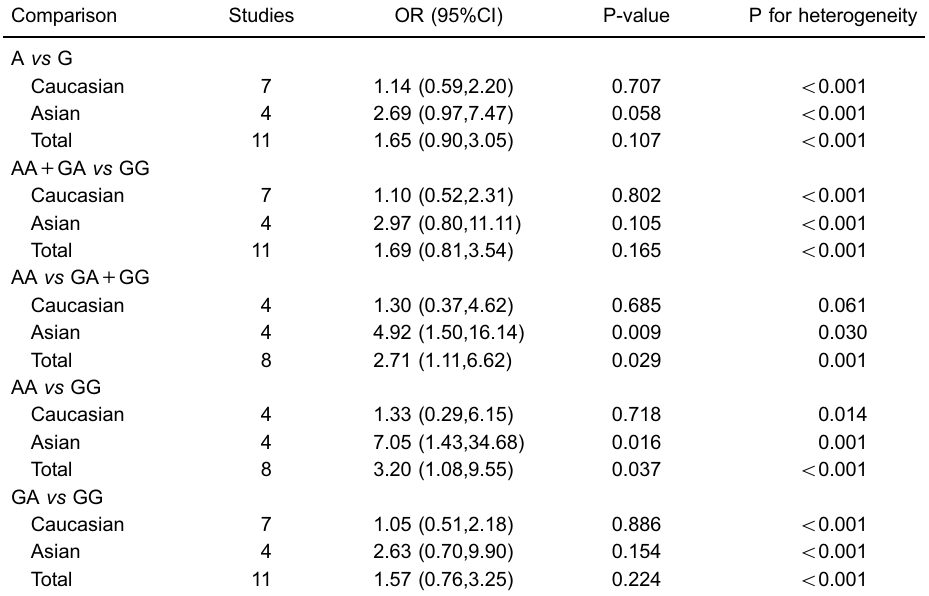
Table 4. Meta-analysis of association between TNF- a rs1800629 polymorphism and the risk of